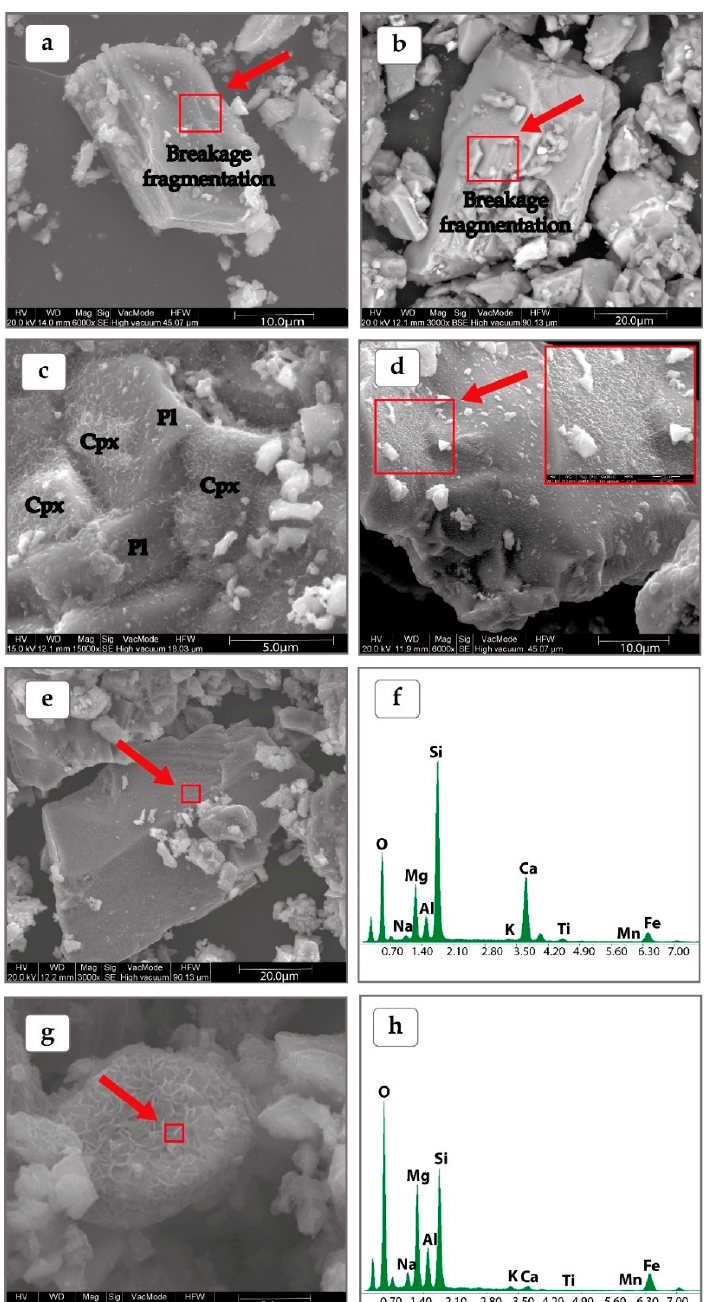
Figure 5. SEM images of a few crystals, before and after treatments: ( a ) traces of mechanical erosion on unaltered plagioclase ( b ) traces of breakage fragmentation (red square) on clinopyroxene, after 80 °C treatment, at pH 3.5 (back scattered image) ( c ) Cpx—Pl mixed grain, after 7 days heating at 150 °C in 5.0 pH, showing the early formation of clay coatings on both crystals ( d ) “honeycomb” morphology of the clay coating developed on a clinopyroxene crystal after heating at 150 °C and zoom in the red square ( e ) Coatings developed on a clinopyroxene crystal, after heating at 175 °C in the strongly acidic condition at pH 3.5 ( f ) EDAX spectrum acquired in the red square area of picture (e) ( g ) clay neo-formation with “honeycomb” morphology entirely covering the clinopyroxene crystal surface at 175 °C and pH 3.5 ( h ) EDS spectrum related to the red square area of picture (g) ( a , c–e , g ) morphological images. Cpx = clinopyroxene; Pl = plagioclase.